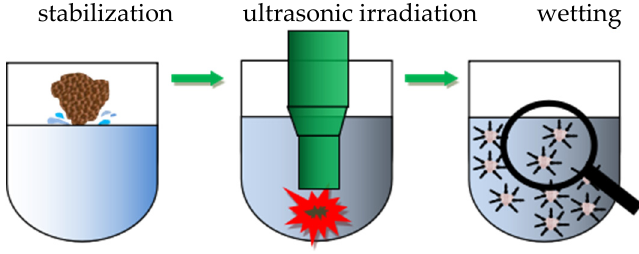
Figure 11. Particle stabilization mechanism.